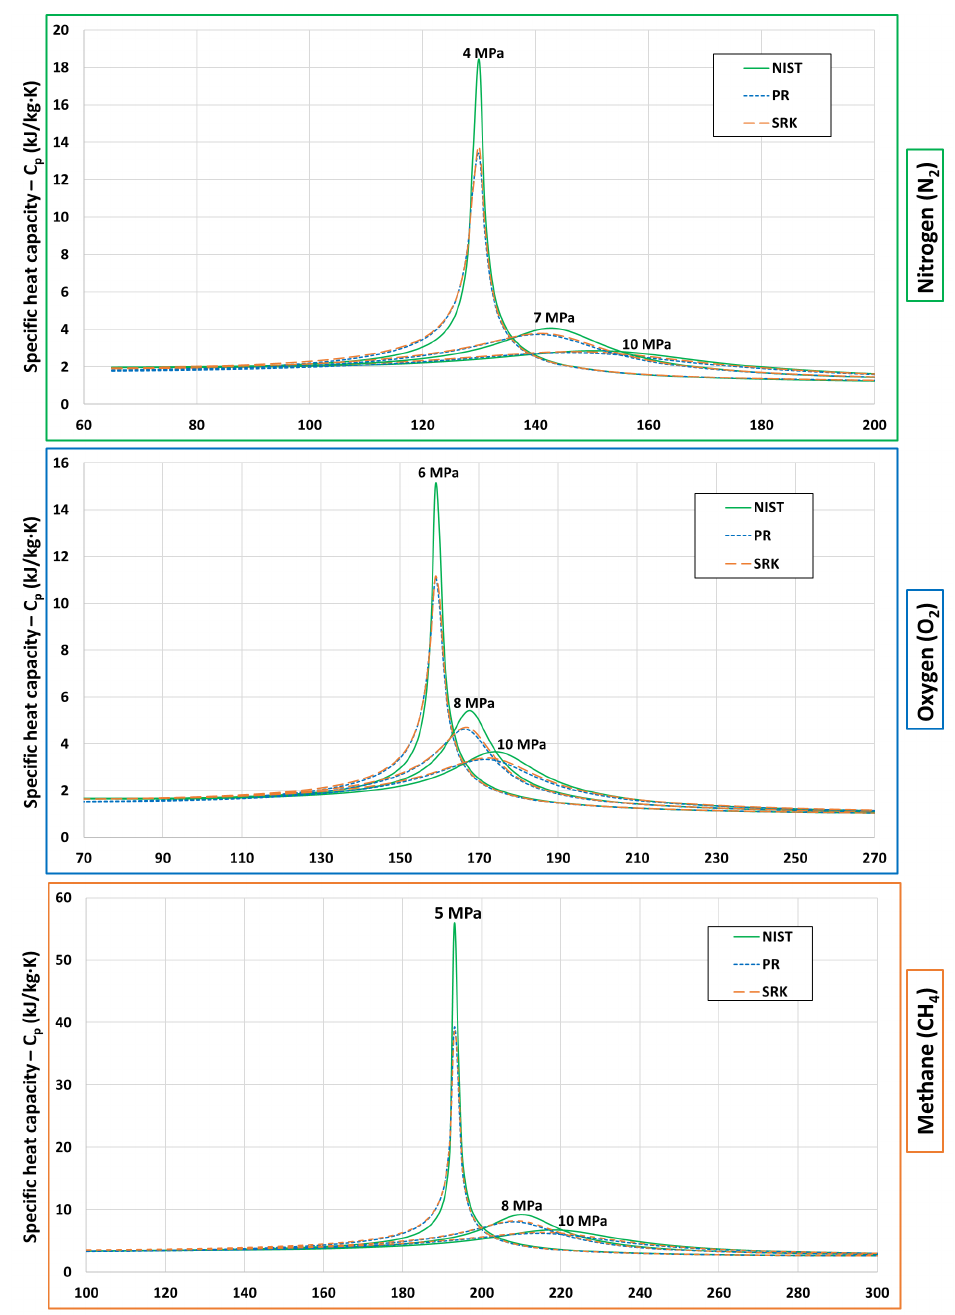
Figure 4. Plots of estimated enthalpy using density from PR and SRK compared against NIST for cryogenic fluids (N 2 , O 2 and CH 4 ) at three supercritical